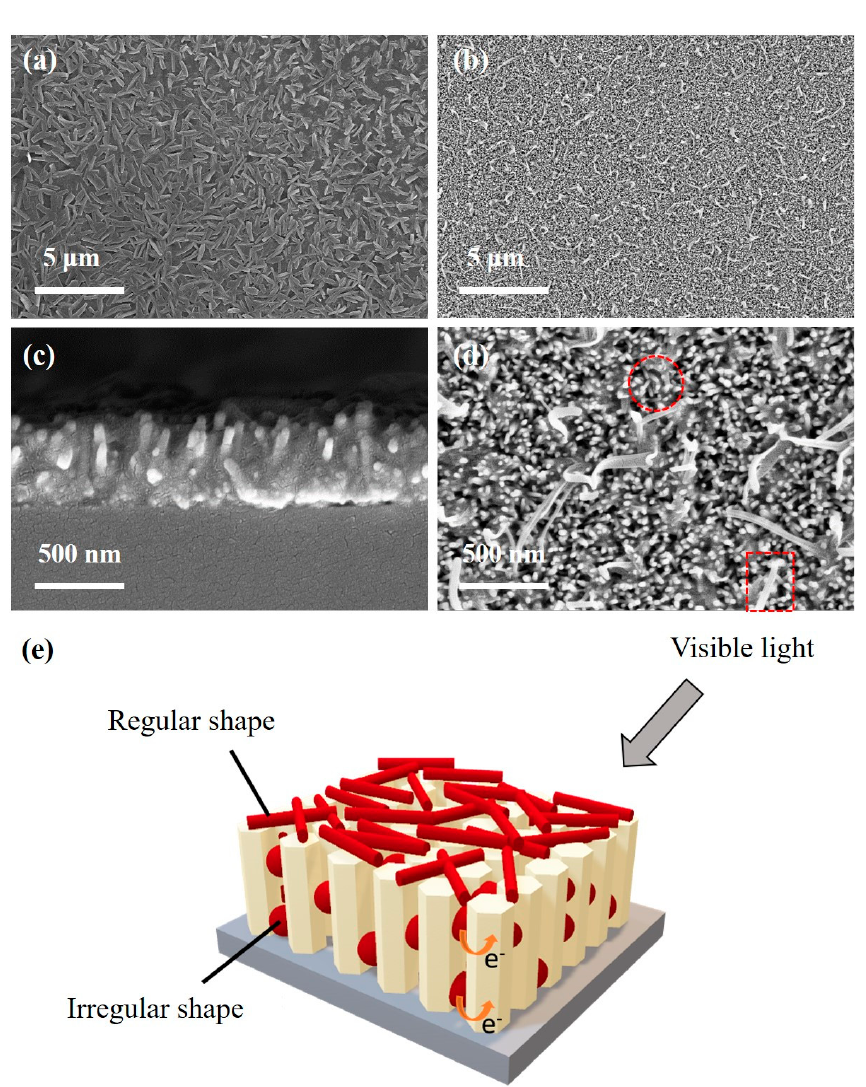
Figure 2. ( a ) Top − view SEM image of BIQ on a SiO 2 /Si substrate. ( b ) Top − view and ( c ) cross − sec- Figure 2. ( a ) Top-view SEM image of BIQ on a SiO 2 /Si substrate. ( b ) Top-view and ( c ) cross-sectional tional SEM image of BIQ/ZnO NRs. ( d ) Magnified top − view SEM image of ( c ). ( e ) Schematic illus- SEM image of BIQ/ZnO NRs. ( d ) Magnified top-view SEM image of ( c ). ( e ) Schematic illustration of tration of BIQ/ZnO NRs. BIQ/ZnO